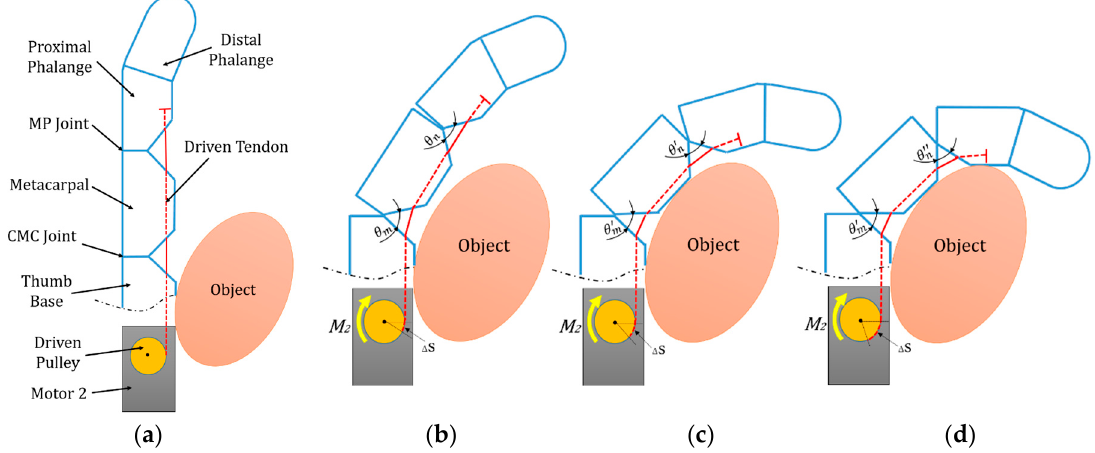
Figure 8. Adaptive flexion in power grasping: ( a ) full extension state; ( b ) approach to object; ( c ) carpometacarpal (CMC) joint blocked by object; ( d ) fully adaptive flexion state.